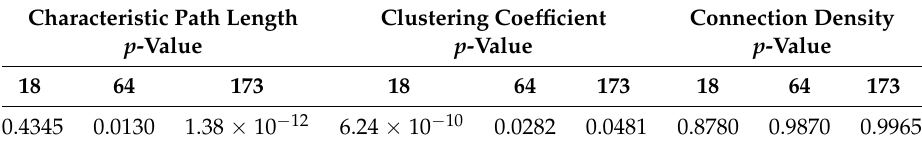
Table 1. Results of Kruskal–Wallis test.